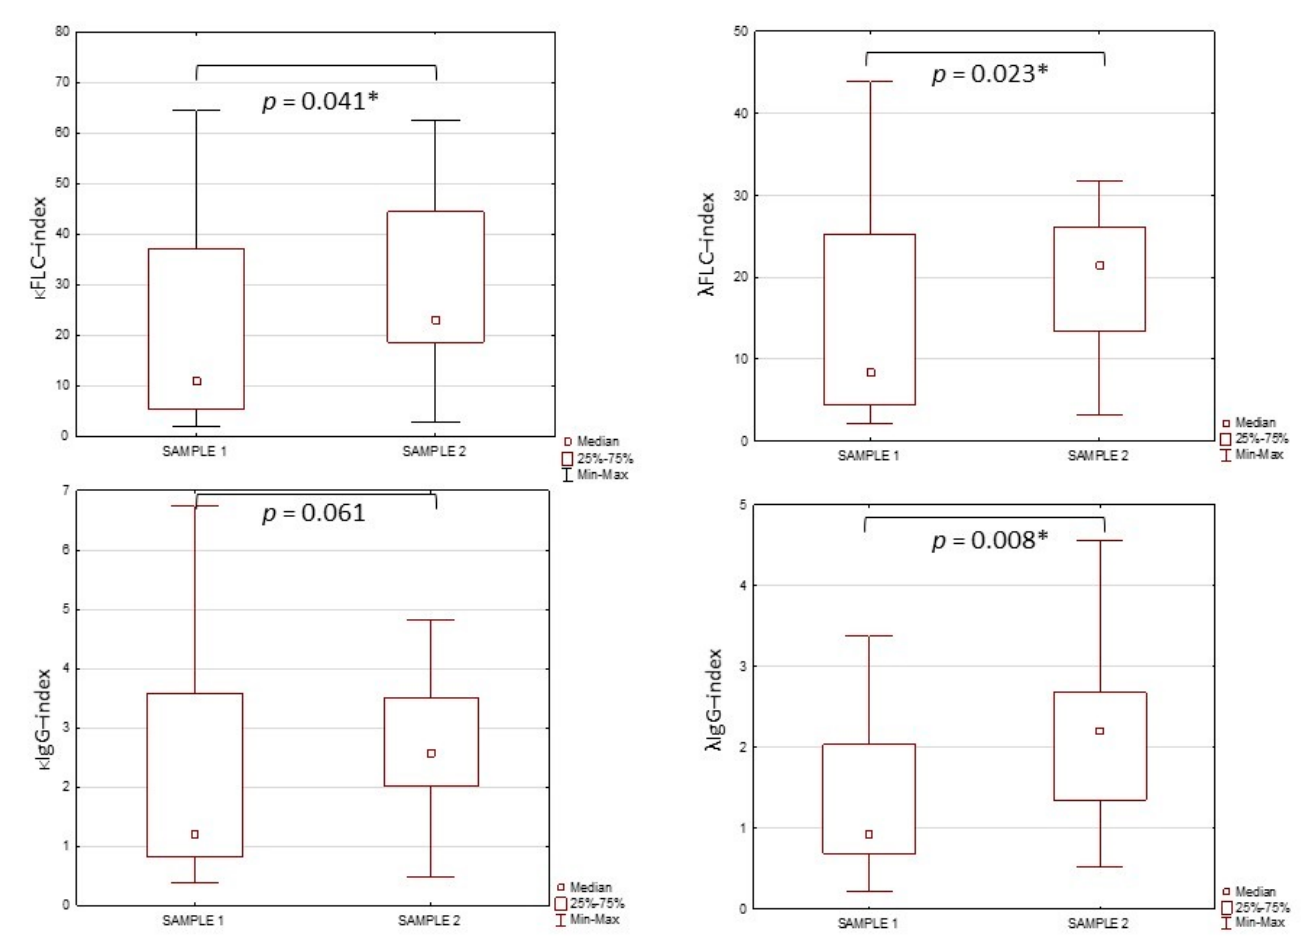
Figure 1. The values of κ FLC-index, λ FLC-index, κ IgG-index and λ IgG-index in tested groups. * —significant differences between tested groups ( p < 0.05).